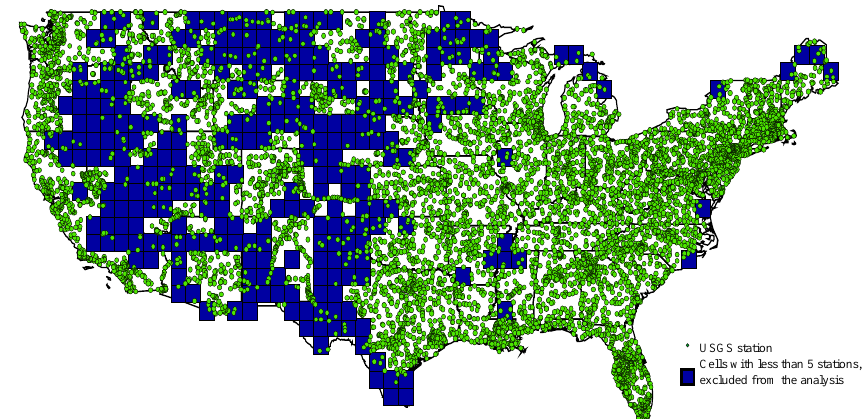
Figure 2. The distribution of the USGS stream gauging stations (green dots). The blue squares indicate those 1 ◦ × 1 ◦ grids containing less than five stations and excluded from the study.